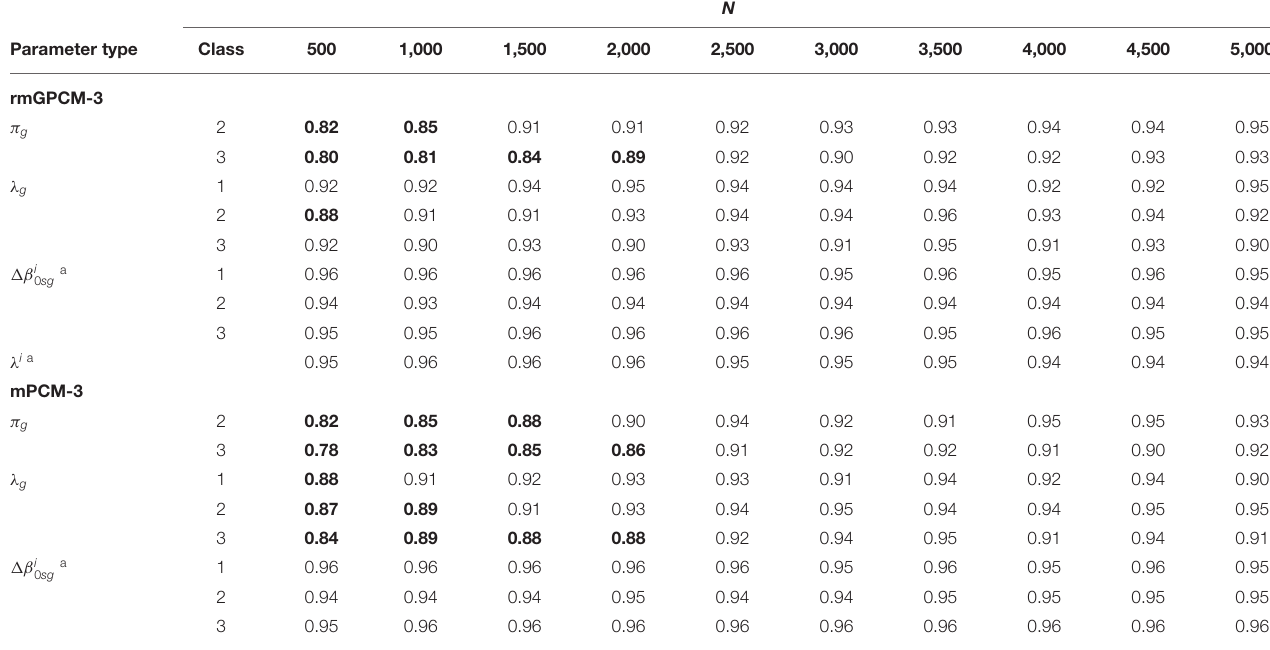
TABLE 5 | Coverage for parameters of the rmGPCM-3 and the mPCM-3 under the condition of a true three-class mixture and a 5-item scale with 11 categories.